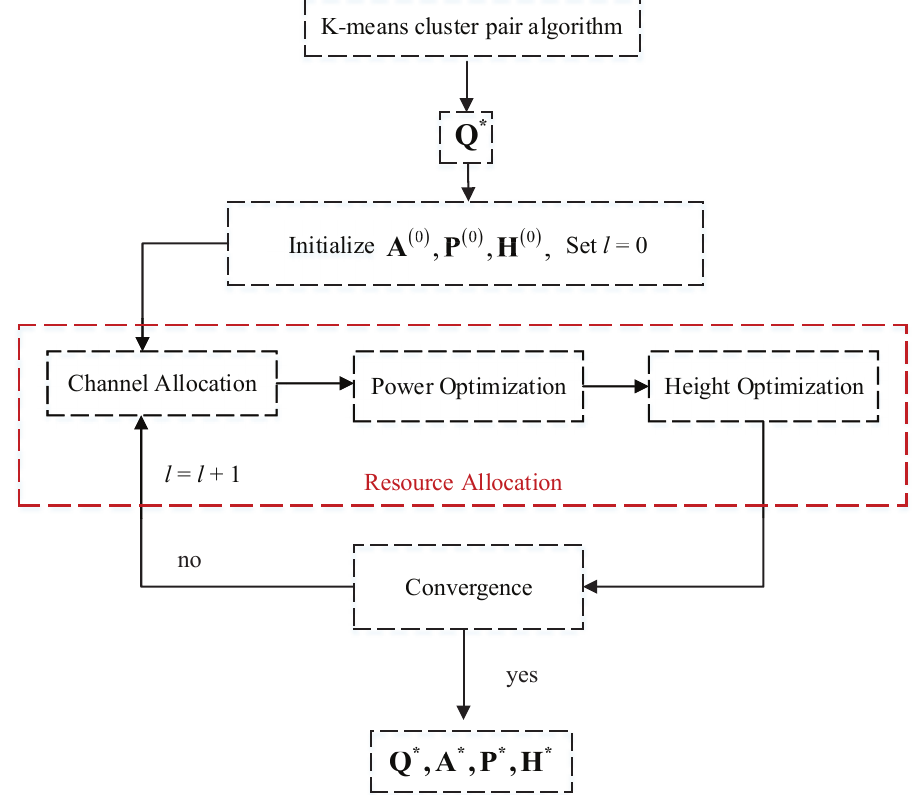
Figure 2. Iterative framework of our proposed